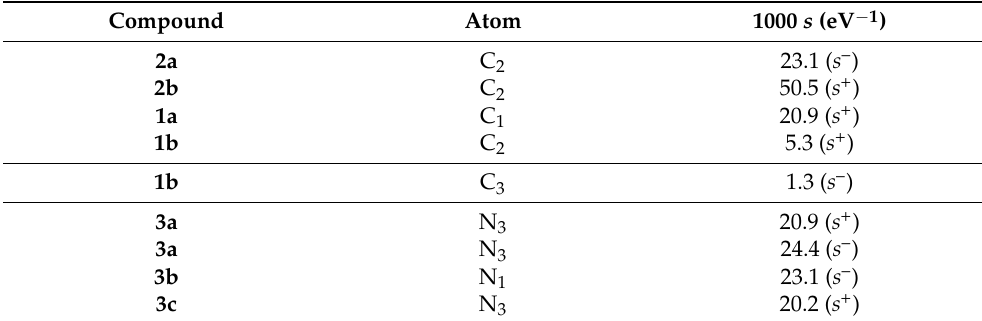
Table 3. Atoms with the largest local softness s (eV − 1 ), calculated at the M08-HX/pcseg-3//M08- HX/pcseg-2 level, within the investigated allenes and azides.